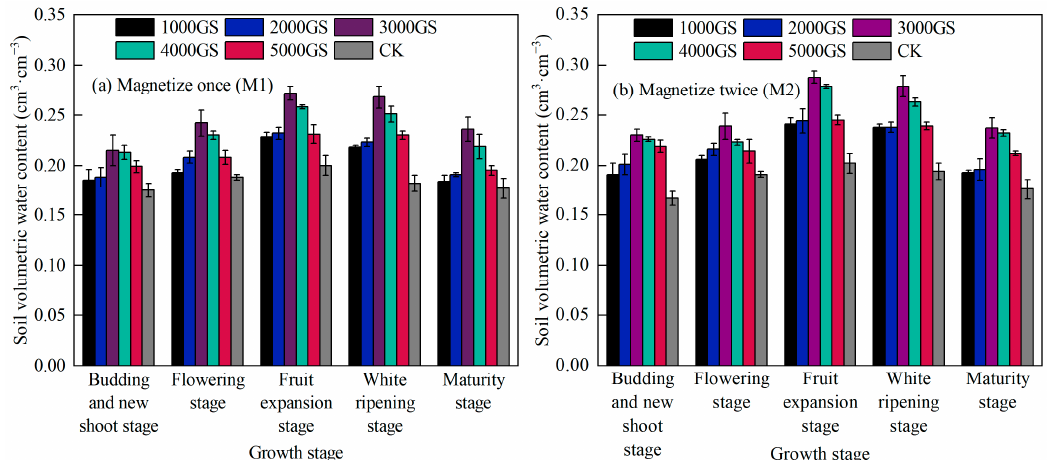
Figure 6. Changes in soil volumetric water content during the growth period of jujube treated with magnetized water drip irrigation. M1 and M2 represent once magnetized and twice magnetized water, respectively.